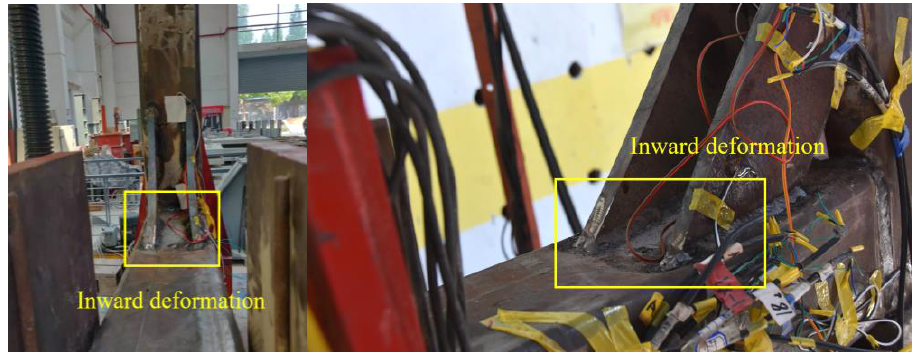
Figure 15. Inward deformation of the beam.